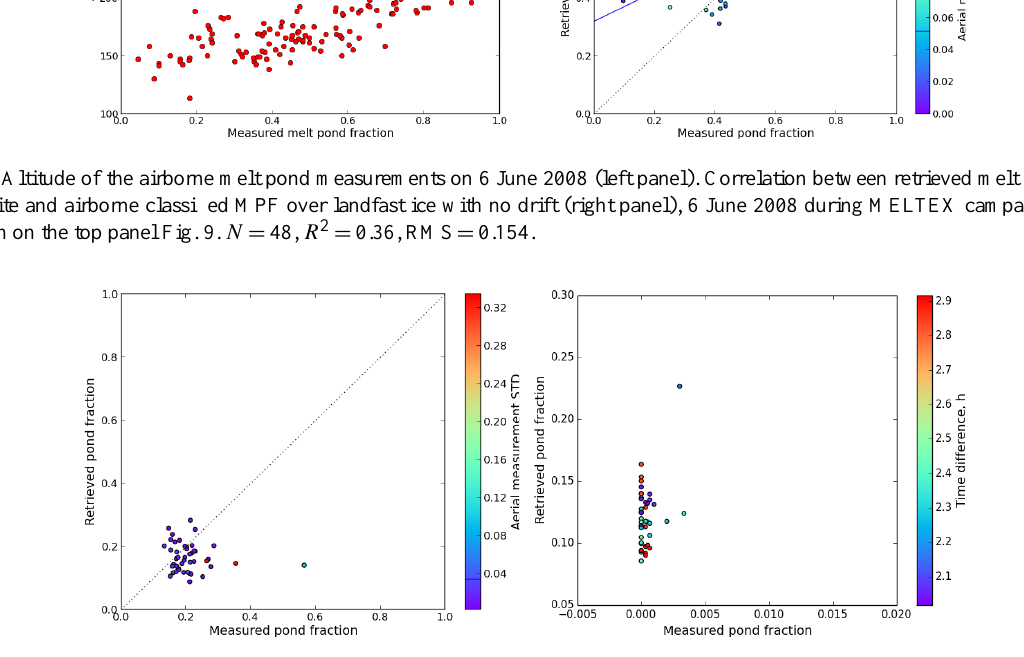
Figure 12. Correlation between retrieved melt pond fractions from satellite- and airborne-classified MPs (melt ponds) over MYI (no drift, ice pack), 21 July 2011, NOGRAM-2, 2011, campaign north of Greenland (left panel). N = 40, R 2 = 0.004. RMS = 0.065 and over FYI, 3 June 2008, MELTEX 2008 (large floes but drift + large time difference) (right panel), N = 44, R 2 = 0.13, RMS = 0.123. See Fig. 2 for locations of the NOGRAM-2 and MELTEX campaigns.